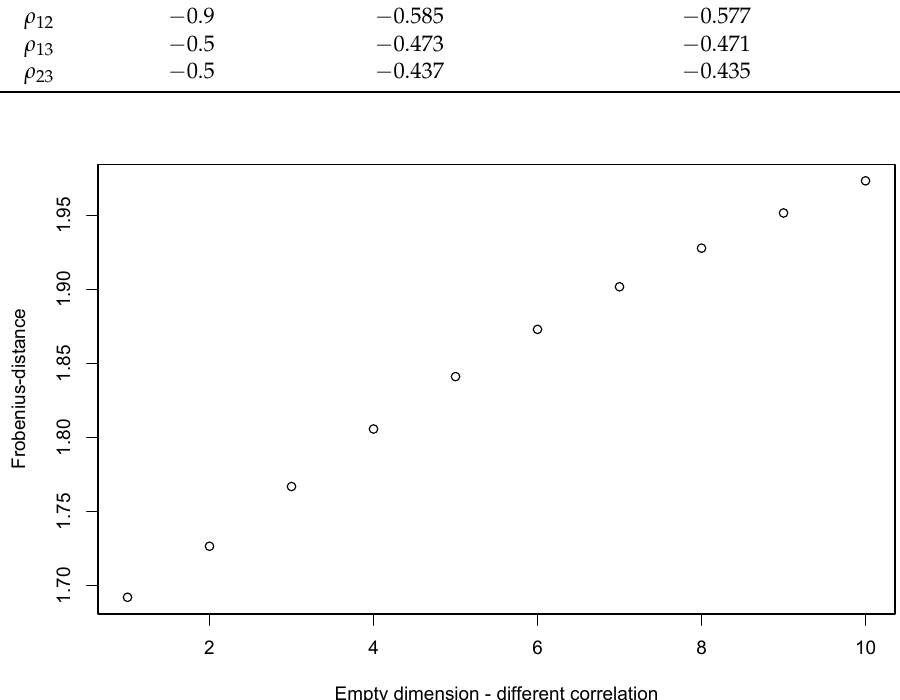
Table 4. Modification of initial correlation coefficients due to the addition of a new risk. Coef.